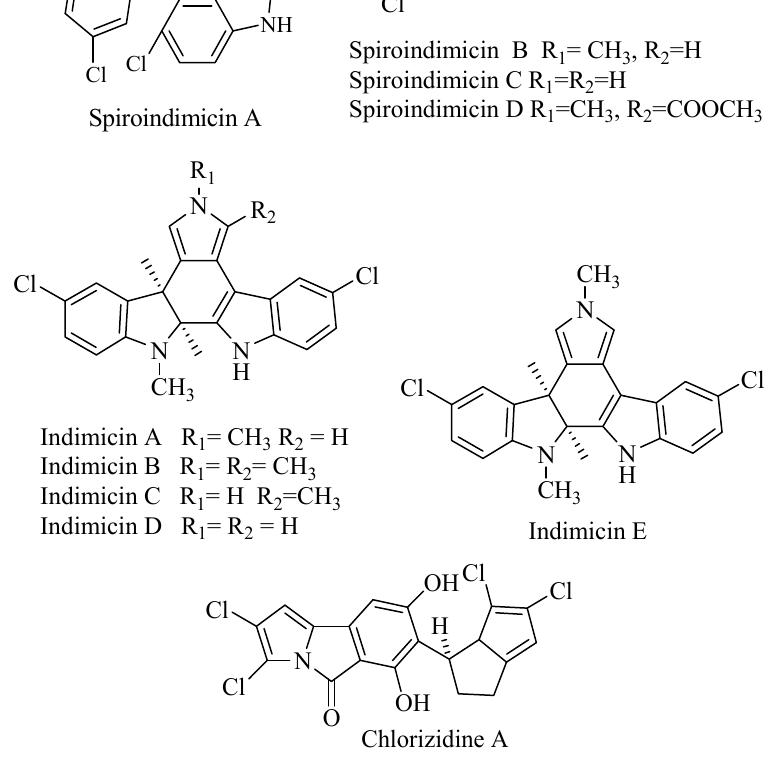
Figure 2. Halogenated alkaloid.